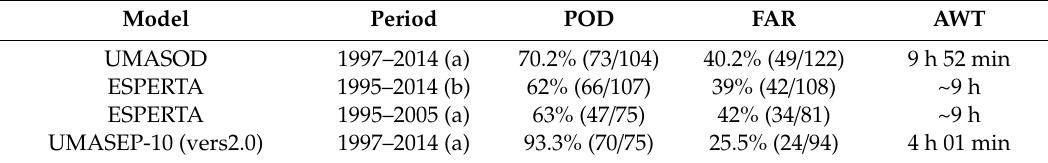
Table 5. Comparison of results of the di ff erent models. UMASOD, University of Malaga predictor